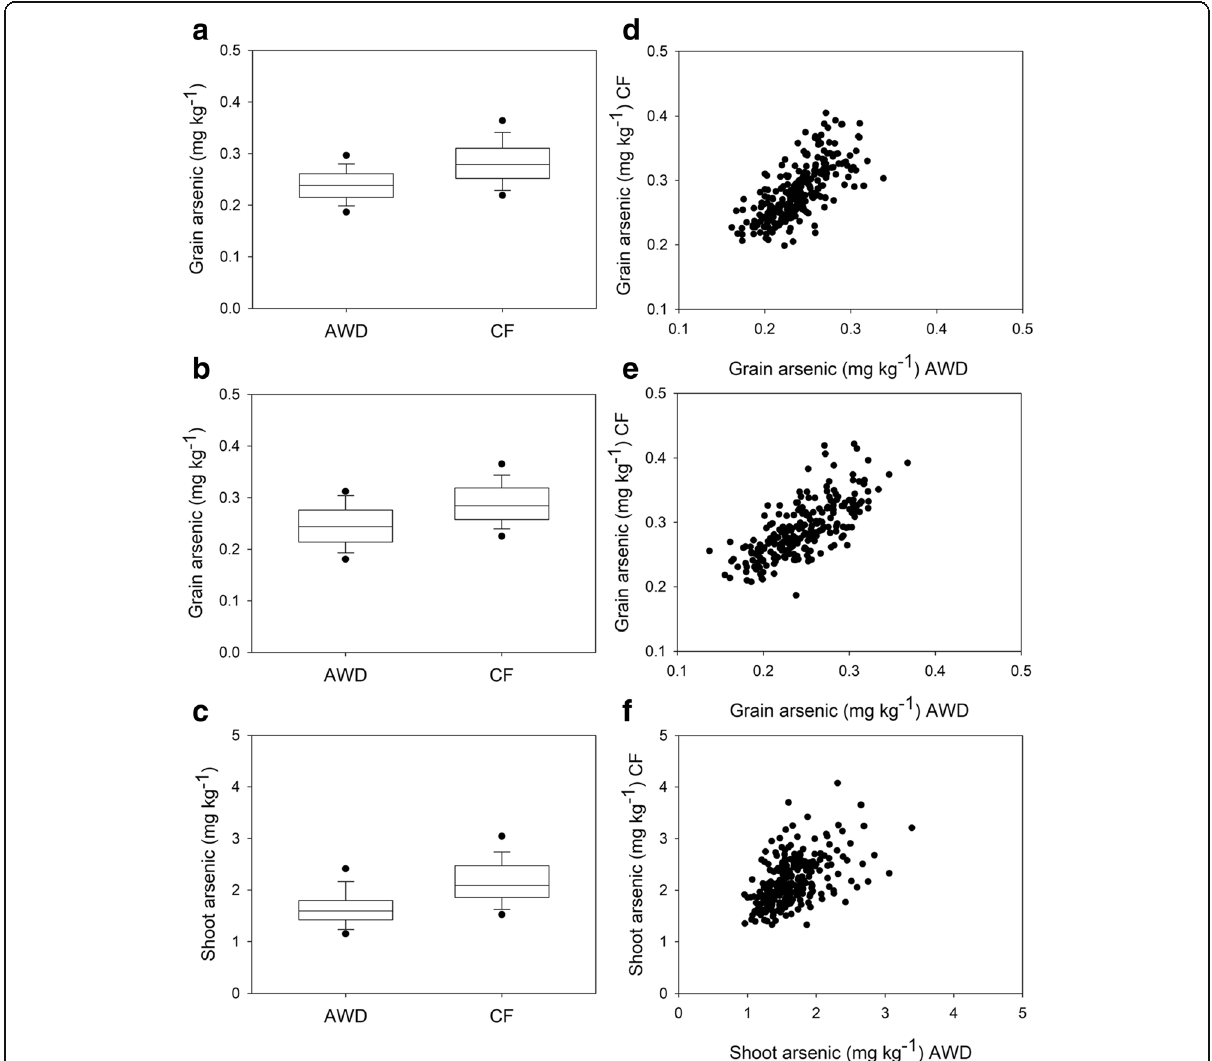
Fig. 1 Grain arsenic 2013 ( a ), 2014 ( b ), and shoot arsenic ( c ). Correlations grain arsenic 2013 ( d ), 2014 ( e ), and shoot arsenic ( f